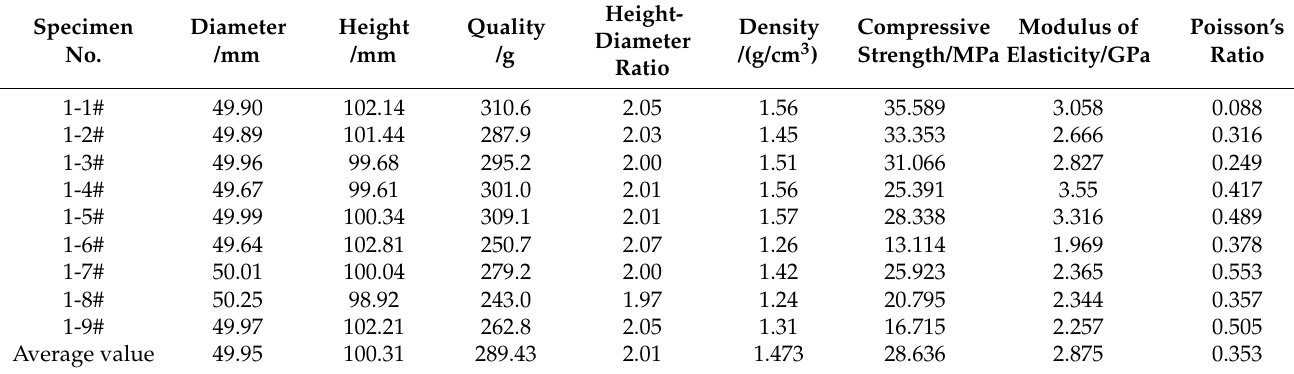
Table 1. Test results of hard coal